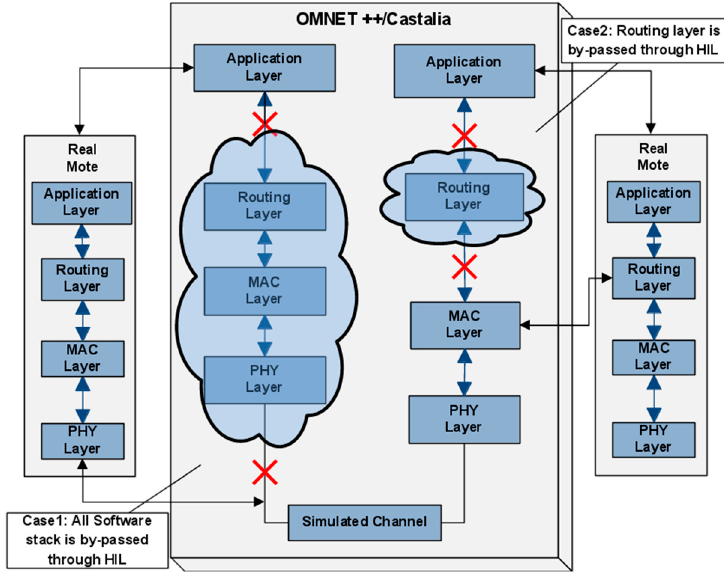
Figure 15. Processing Delay HiL Scenario.